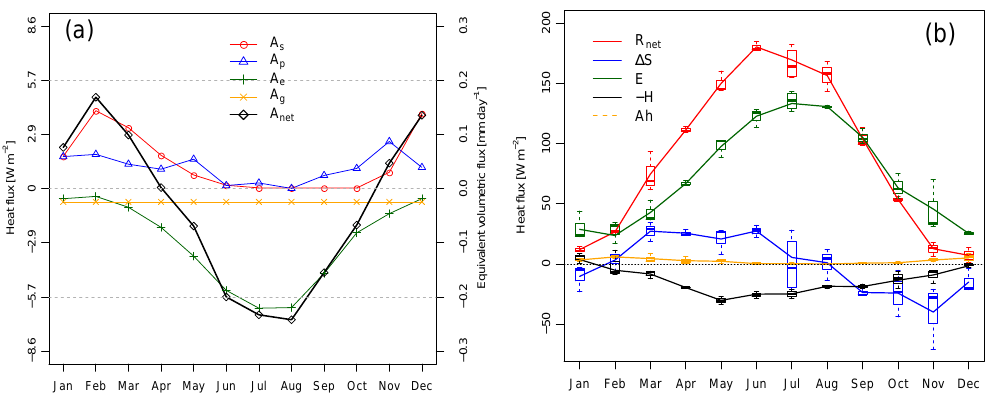
Figure 4. Monthly mean of (a) advected terms and (b) main components of the heat budget. In (b) the box indicates the range of the upper and lower quartiles with the median shown using bold horizontal line and the minimum and maximum shown with notches; line segments go through mean values.